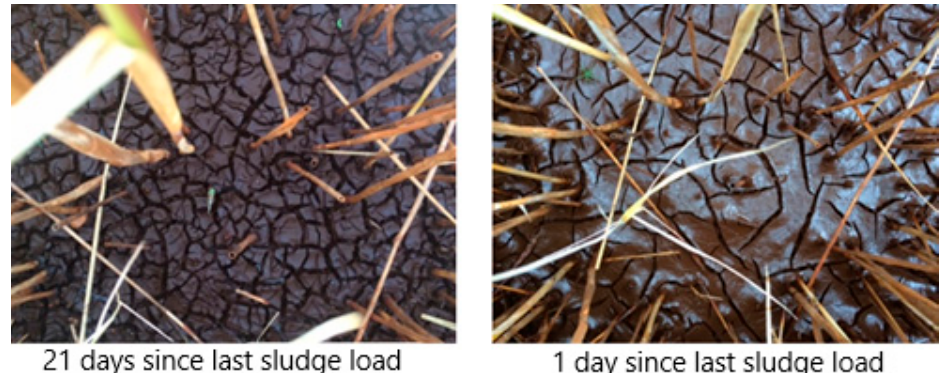
Figure 12. Pictures of the residual sludge surface at the Whitacre pilot STRB at the end ( left ) and at the start of the resting period ( right ) (courtesy of Orbicon).